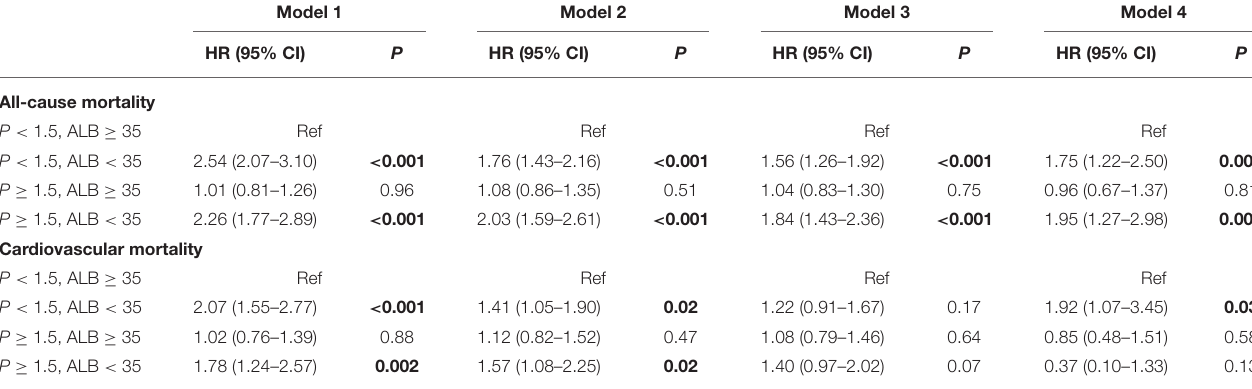
TABLE 4 | Analysis in associations between phosphorus and all-cause, cardiovascular mortality separately, and by albumin and phosphorus levels, respectively.